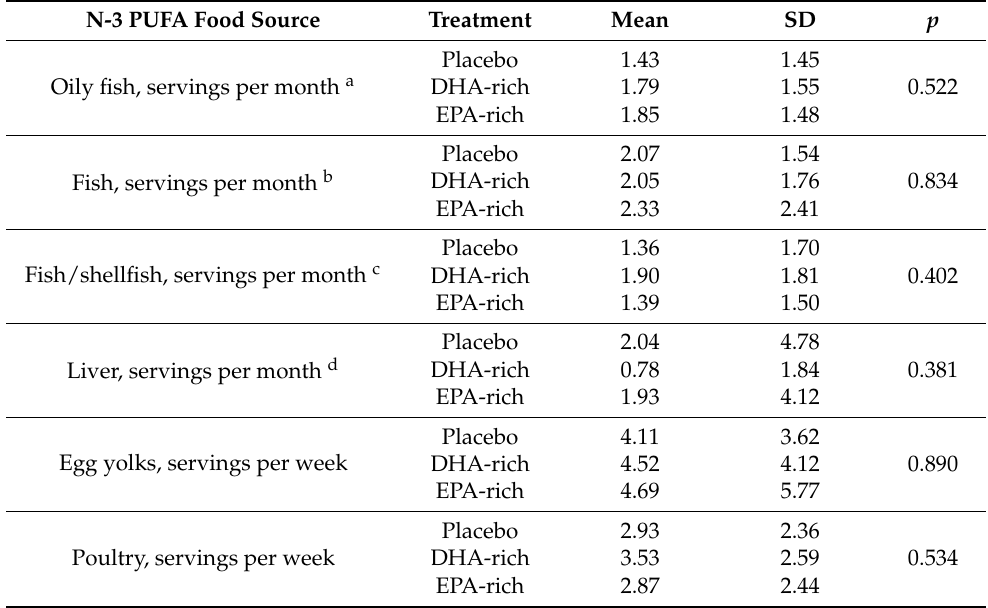
Table 2. Outcomes from the DHA food frequency questionnaire for the 84 participants who completed all aspects of the study. Group differences were assessed using separate one-way ANOVAs; resulting p values from these analyses are